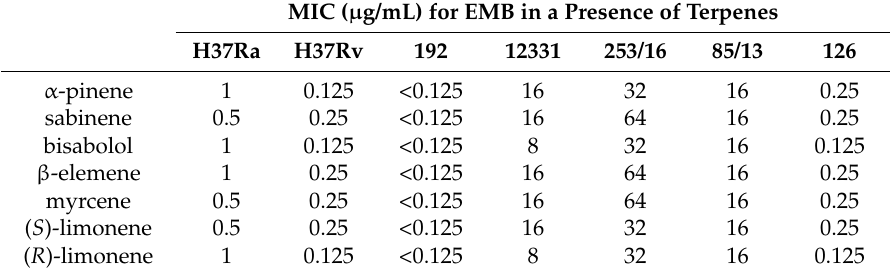
Table 3. The minimal inhibitory concentration values (MIC) obtained for antibiotics tested in the presence of subinhibitory concentrations of terpenes